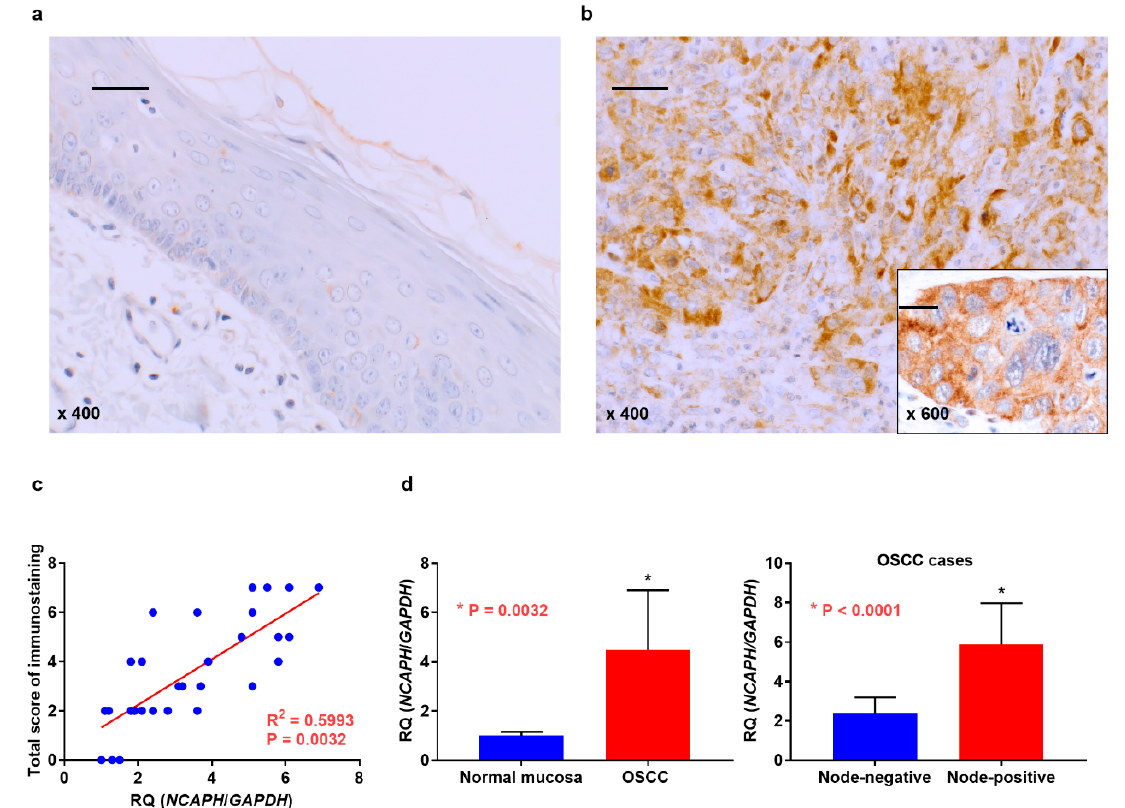
Figure 1. Expression analysis of NCAPH. ( a ) Weak and/or no NCAPH expression was detected in the normal oral mucosa. ( b ) NCAPH expression was observed in the cytoplasm in oral squamous cell carcinoma (OSCC). ( c ) Association of NCAPH expression with immunohistochemical grade in OSCC cases. ( d ) NCAPH expression was detected using quantitative reverse transcription polymerase chain reaction in samples of OSCC and normal oral mucosa. Differential expression of NCAPH in normal mucosa and OSCC (right) and metastatic and non-metastatic OSCC cases (left). scale bar 100 μ m. Table 1. Relationship between NCAPH expression and clinicopathological parameters.